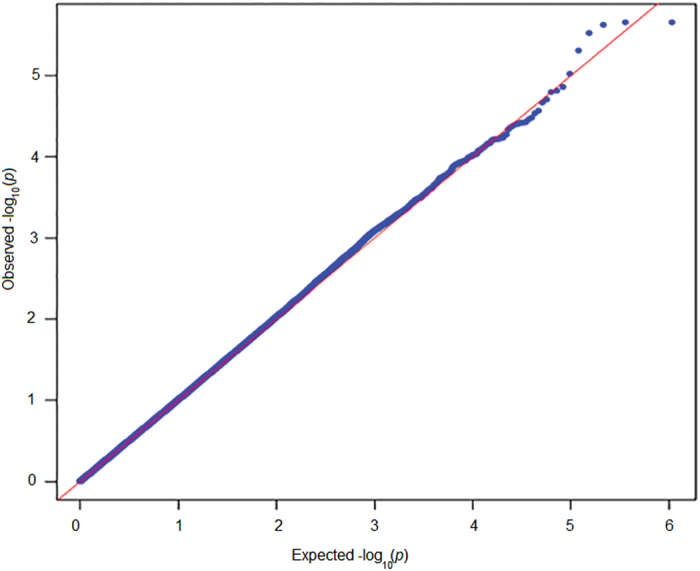
Quantile-quantile (QQ) plot for the calculated p-value in discovery phase.The -log10 of p-values observed for the association of SNPs in discovery phase genome wide association analysis under additive model adjusted for age, sex BMI, PC1 and PC2 (black symbols) are plotted against the theoretical -log10 p-values expected under the null hypothesis (red line). The genomic control inflation factor (λ) was estimated to be 1.06.